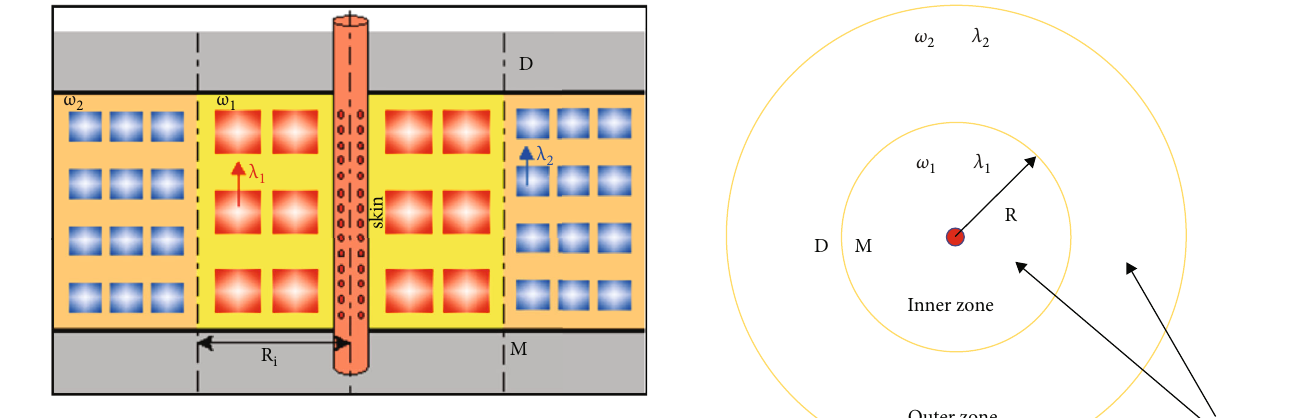
Figure 1: Schematic diagram of fl uid fl ow in a dual-media composite reservoir model (cite from KAPPA).